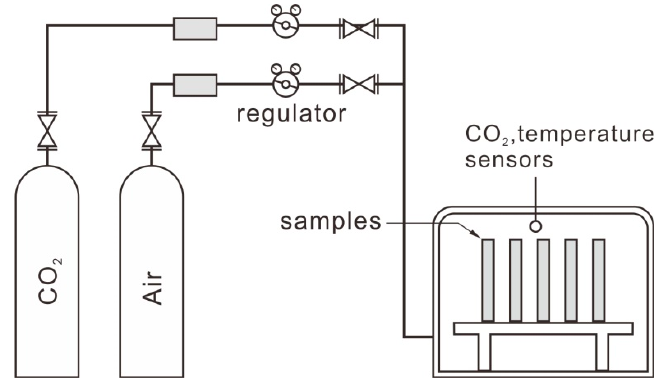
Figure 2. CO 2 curing chamber.